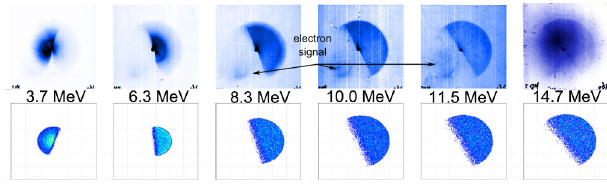
FIG. 3. Proton imprint in the RCF stack at 36.8 cm behind the source: experimental (upper) and simulation (lower sequence) results. In both cases the size of a single film is 60 mm (cid:3) 60 mm . Additionally, an electron signal can be seen in the experimental data in the lower left quarter.